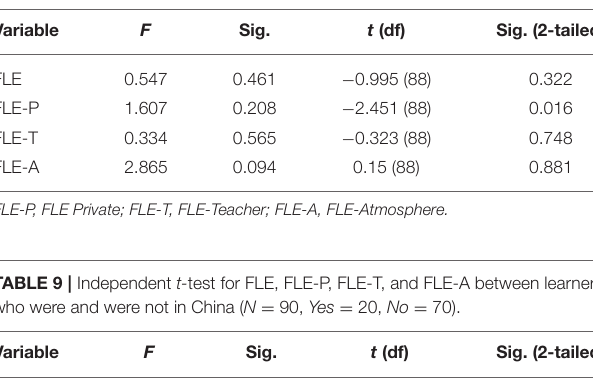
TABLE 8 | Independent t- test for FLE, FLE-P, FLE-T, and FLE-A between male and female CSL learners ( M = 40, F = 50).